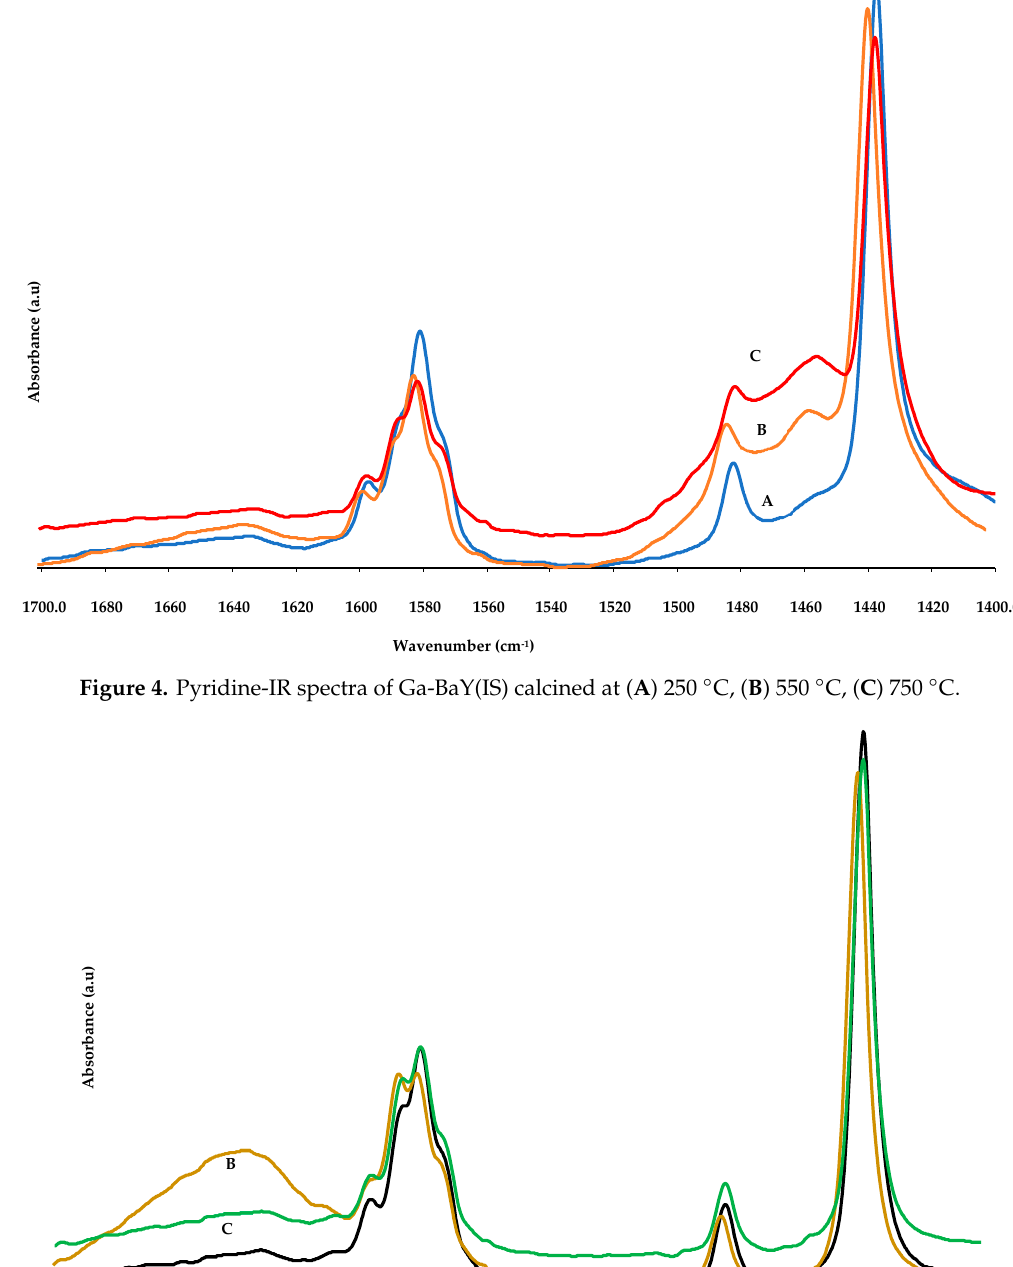
Figure 5. Pyridine-IR spectra of Ga-BaY(Sil) calcined at ( A ) 250 °C, ( B ) 550 °C, ( C ) 750 °C.